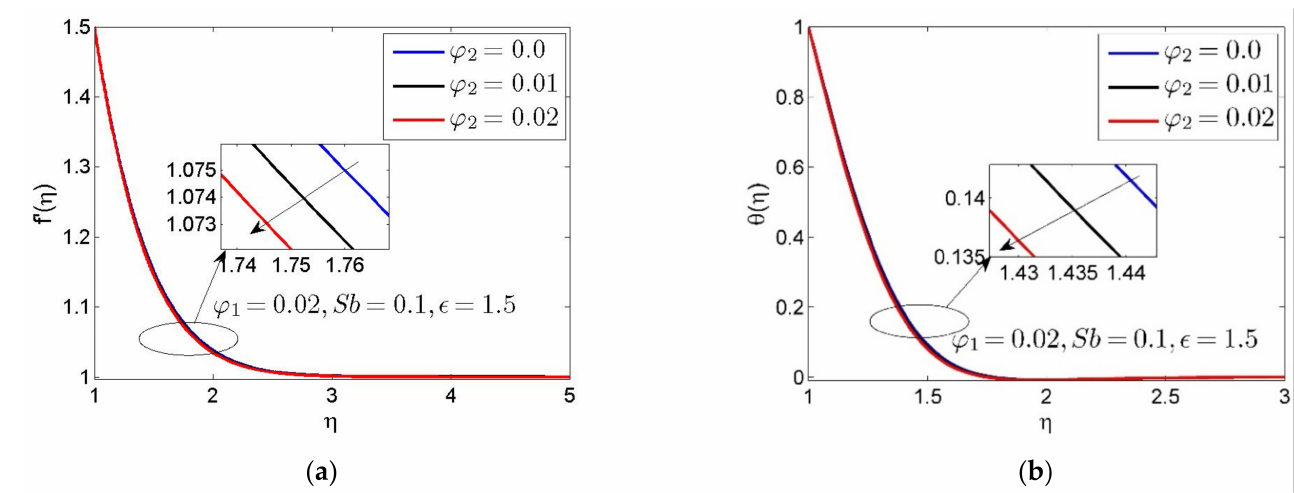
Figure 3. Influences of ϕ 2 on f ( η ) and θ ( η )